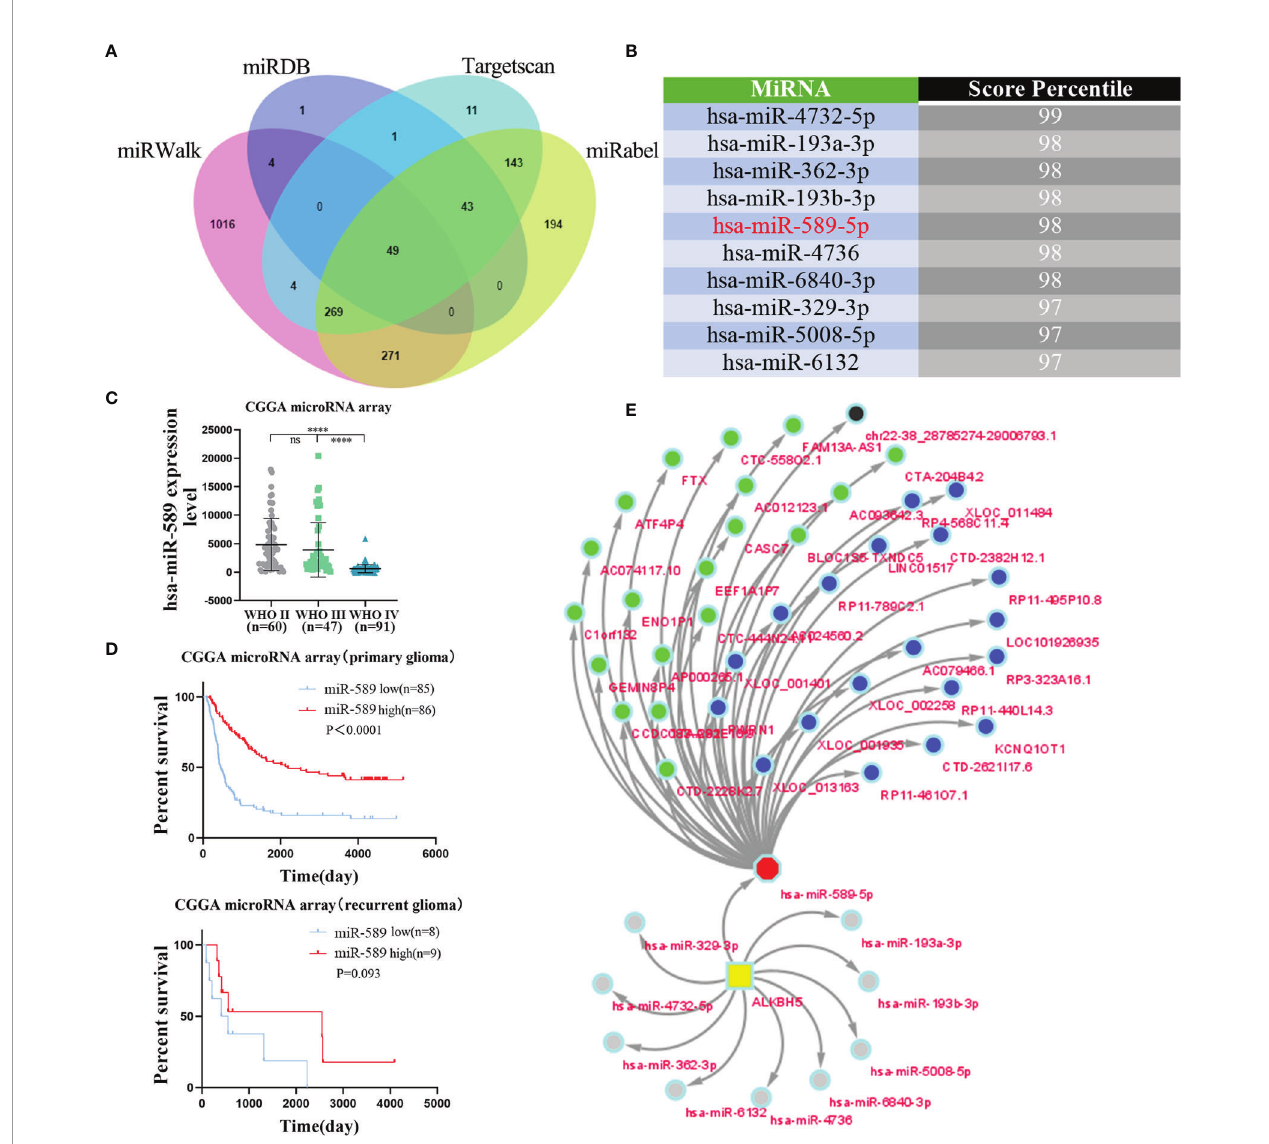
FIGURE 8 | The lncRNA-miRNA-ALKBH5 regulatory network constructed. (A) The upstream miRNAs of ALKBH5 were predicted by miRWalk, miRDB, Targetscan and miRabel databases and the intersection was taken (49 intersection miRNAs). (B) The top 10 miRNAs targeting ALKBH5 were displayed in Targetscan database. (C) The relationship between hsa-miR-589 expression and grade in glioma from CGGA microRNA array dataset. (D) The relationship between hsa-miR-589 expression and prognosis in glioma patients from CGGA microRNA array dataset. (E) The lncRNA-miRNA-ALKBH5 regulatory network was constructed by Cytoscape. ns (nonsense), **** P